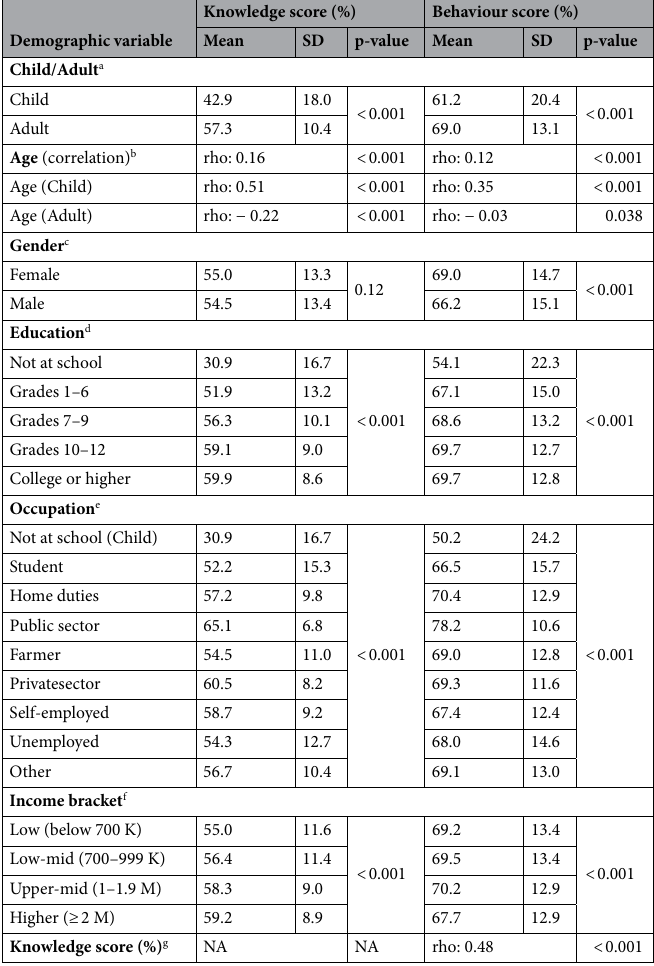
Table 2. Knowledge and behaviour scores by demographic factors. a,c Independent sample t tests